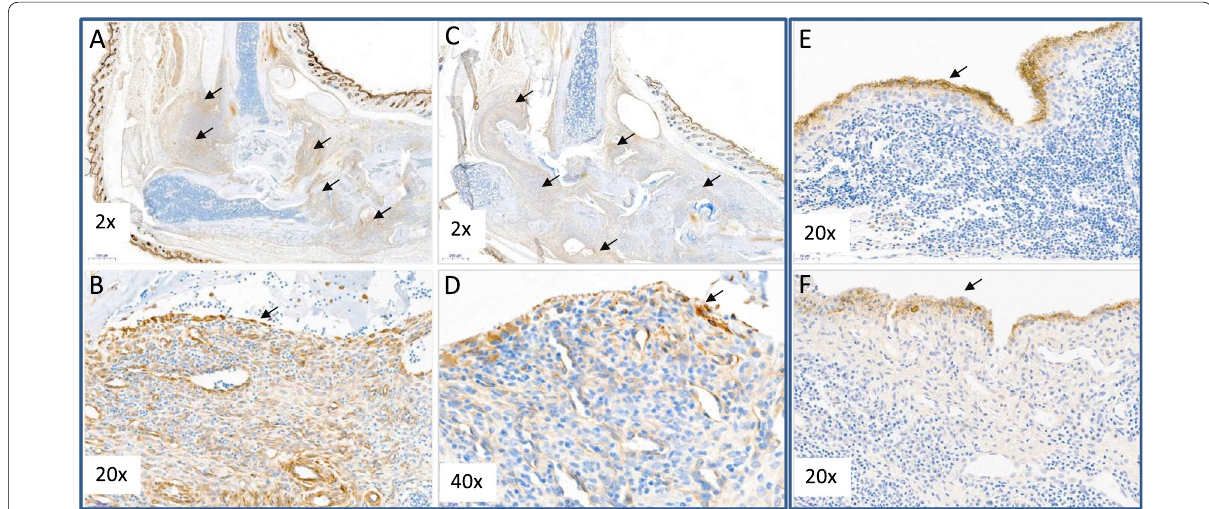
Fig. 4 Immunohistochemistry detection for FnEDA epitope. mCIA ankle( A – D ) and human RA tissue ( E , F ) sections were labeled with anti-FnEDA mAb and detected with HRP-labeled secondary mAb (brown). (N